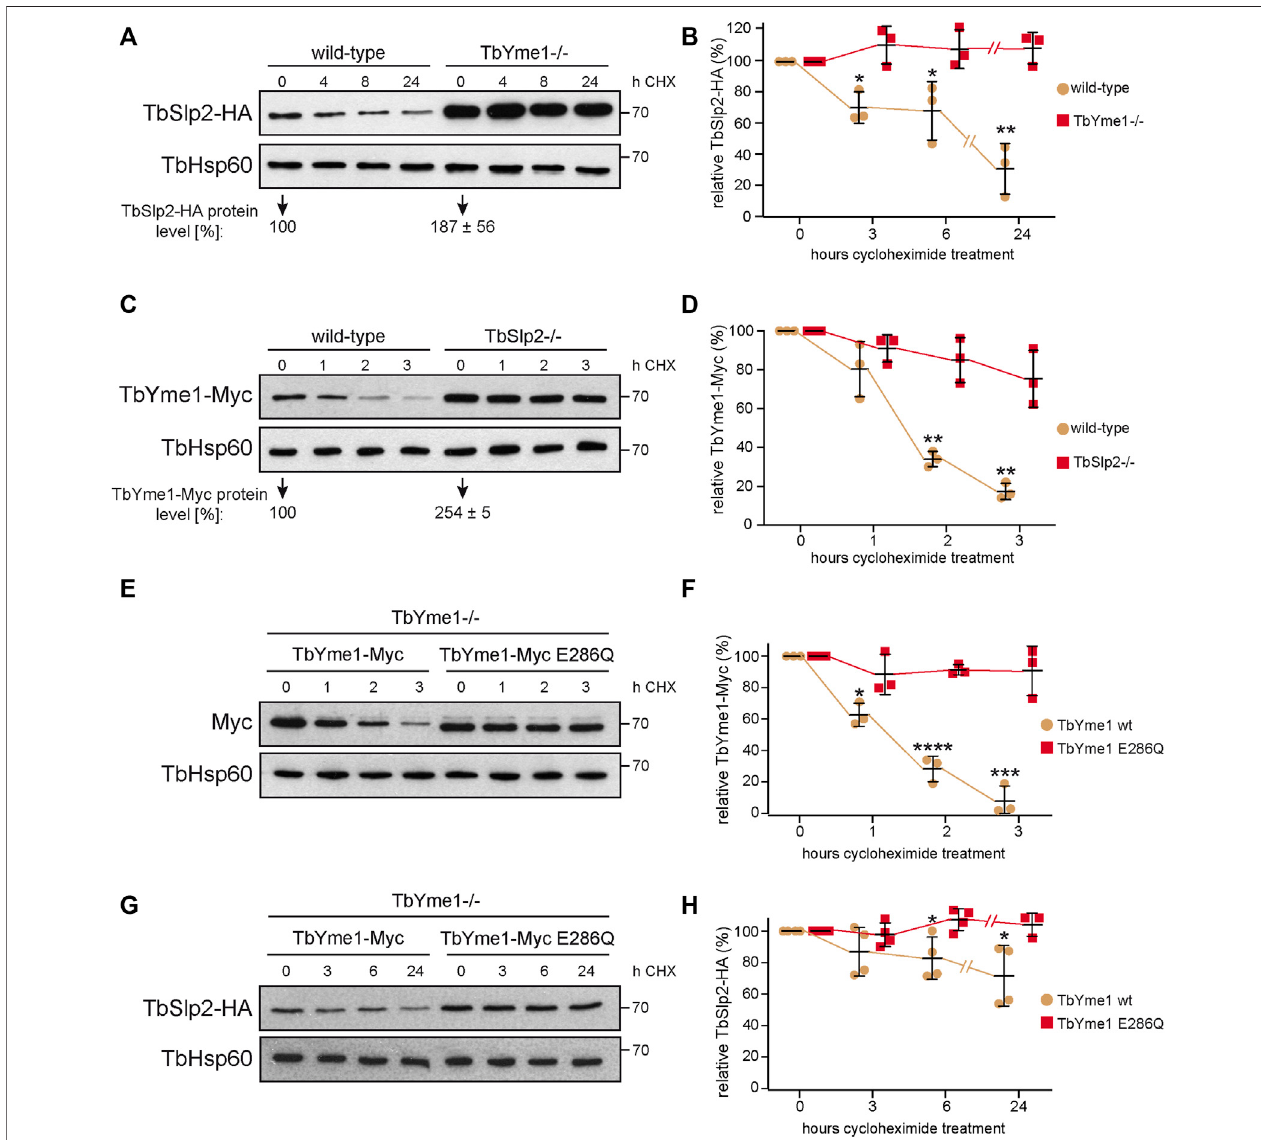
FIGURE4| TbSlp2andTbYme1areinterdependent. (A) Wild-typeandTbYme1 − / − T.brucei expressingTbSlp2-HA insitu weretreatedwithcycloheximide(CHX) for the times indicated. Proteins were separated by SDS-PAGE and analysed by immunoblotting. TbHsp60 was used as a loading control. Normalized TbSlp2-HA proteinlevelsinuntreatedcellsaregivenbelowtheimmunoblots(n ≥ 3). (B) Quanti fi cationofTbSlp2-HAsignalintensitynormalizedtoTbHsp60fromdatashowninA)(n ≥ 3). (C) Wild-type and TbSlp2 − / − parasites expressing TbYme1-Myc were treated with CHX for the times indicated. Proteins were separated by SDS-PAGE and analysedbyimmunoblotting.NormalizedTbYme1-Mycproteinlevelsinuntreatedcellsaregivenbelowtheimmunoblots(n ≥ 3). (D) Quanti fi cationofTbYme1-Mycsignal intensities normalized to TbHsp60 from images depicted in C). (E) Turnover of TbYme1-Myc or TbYme1-Myc E286Q stably expressed in TbYme1 − / − parasites was analysedafterCHXtreatmentfortimesindicated. (F) Quanti fi cationofTbYme1-MycorTbYme1-MycE286QsignalintensitiesnormalizedtoTbHsp60asshowninE). (G) Turnover of TbSlp2-HA after CHX treatment of TbYme1 − / − parasites co-expressing TbYme1-Myc or TbYme1-Myc E286Q. (H) Quanti fi cation of TbSlp2-HA protein levels normalized to TbHsp60 from images shown in G). Students t-test; *: p < 0.05; **: p < 0.01; ***: p < 0.005; ****: p <